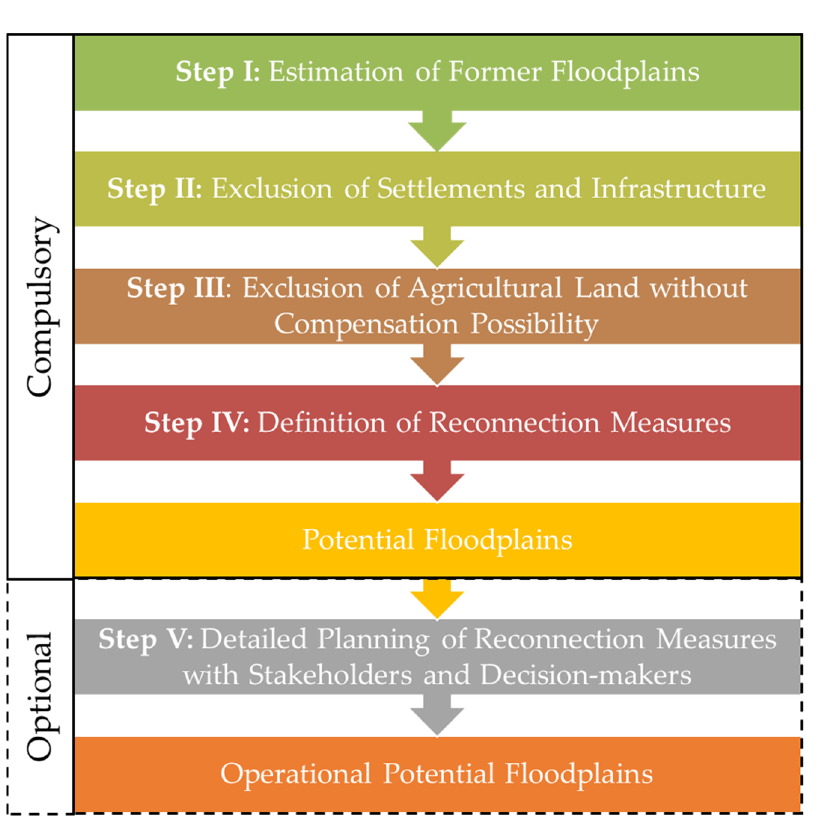
Figure 3. Sequence of the identification method for potential and “operational” potential flood- plains.